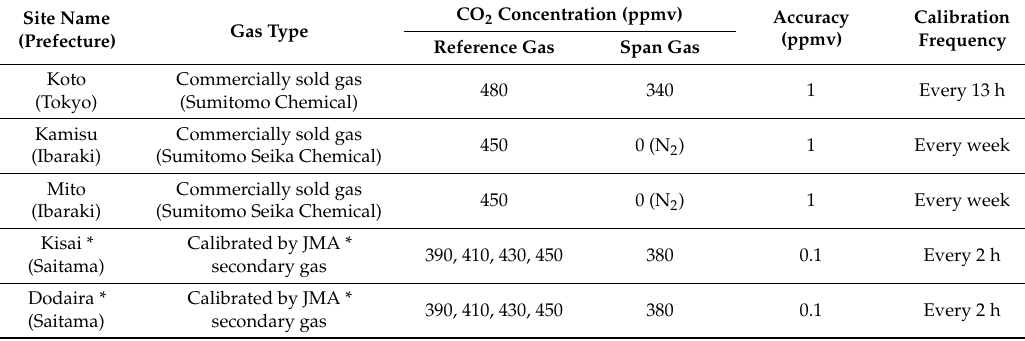
Table 2. Calibration gas and